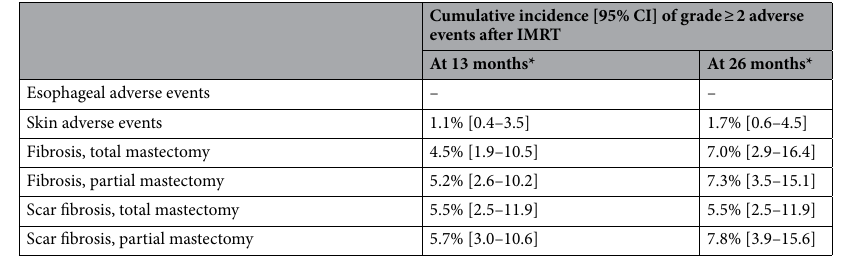
Table 5. Cumulative incidence of medium-term adverse events. *The cumulative incidences are quoted at 13 and 26 months (rather than 12 and 24 months) so as not to underestimate the values, since the annual check- ups often took place slightly later than 12 and 24 months. Skin adverse events were defined as radiodermatitis, ulceration-necrosis, telangiectasia, atrophy, hyperpigmentation or hypopigmentation. With regard to surgical bed fibrosis, only fibrosis absent or of a higher grade on inclusion were